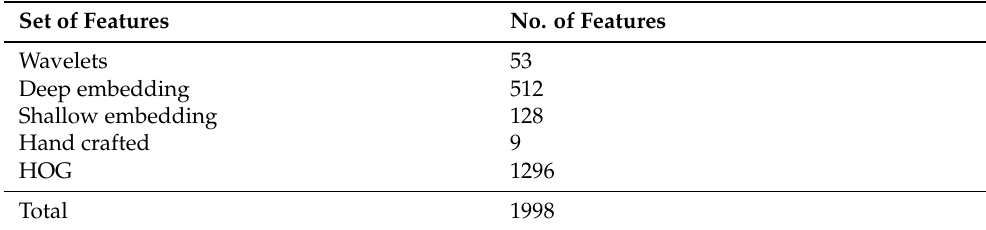
Table 2. Total number of features for each initial feature extraction